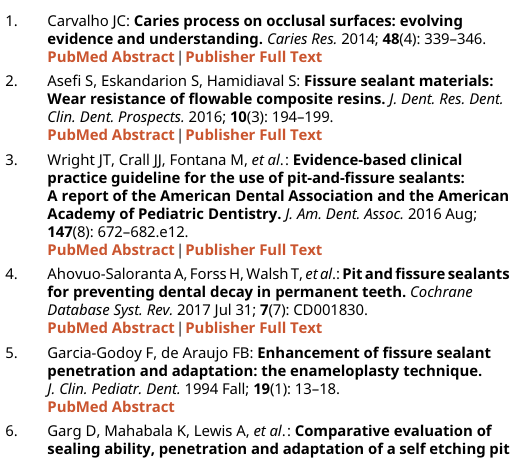
Fighsare: CONSORT checklist and flow diagram for ‘ Comparison of the clinical effectiveness of self-etch sealant with the conventional acid-etch sealant for the retentive ability and marginal integrity in permanent molars: a split mouth one year randomized controlled trial ’